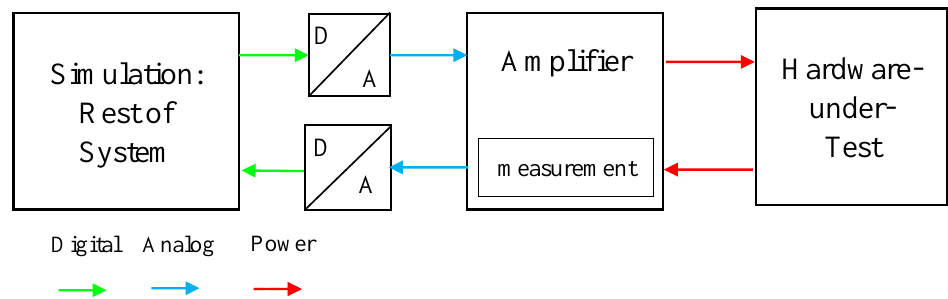
Figure 1. General power hardware-in-the-loop